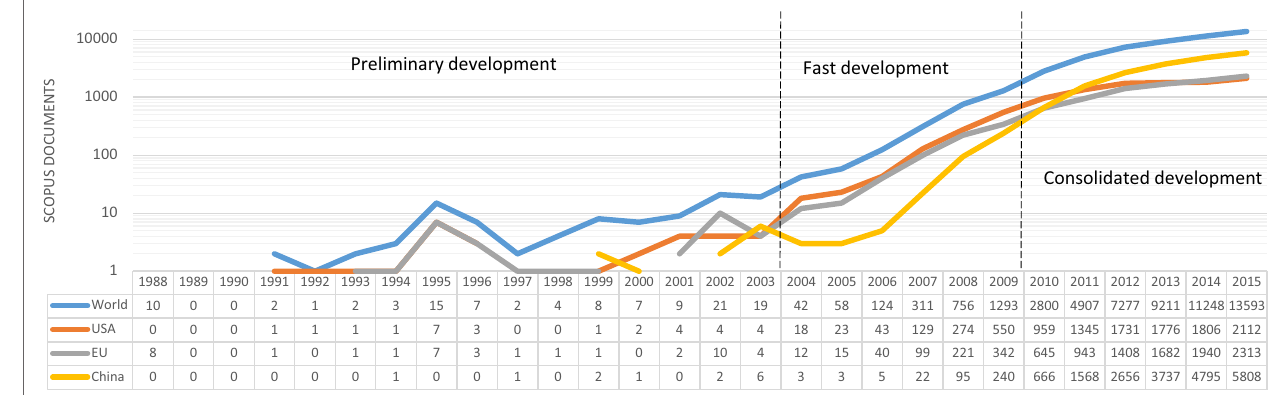
FigUre 1 | Count and evolution of documents on graphene research in Scopus